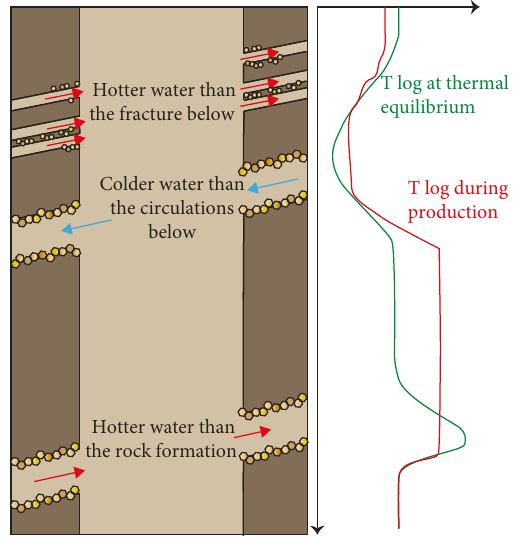
Figure 9: Conceptual model of fl uid circulation in an FZ partly plugged with quartz and illite and the associated T anomalies measured during production and at thermal